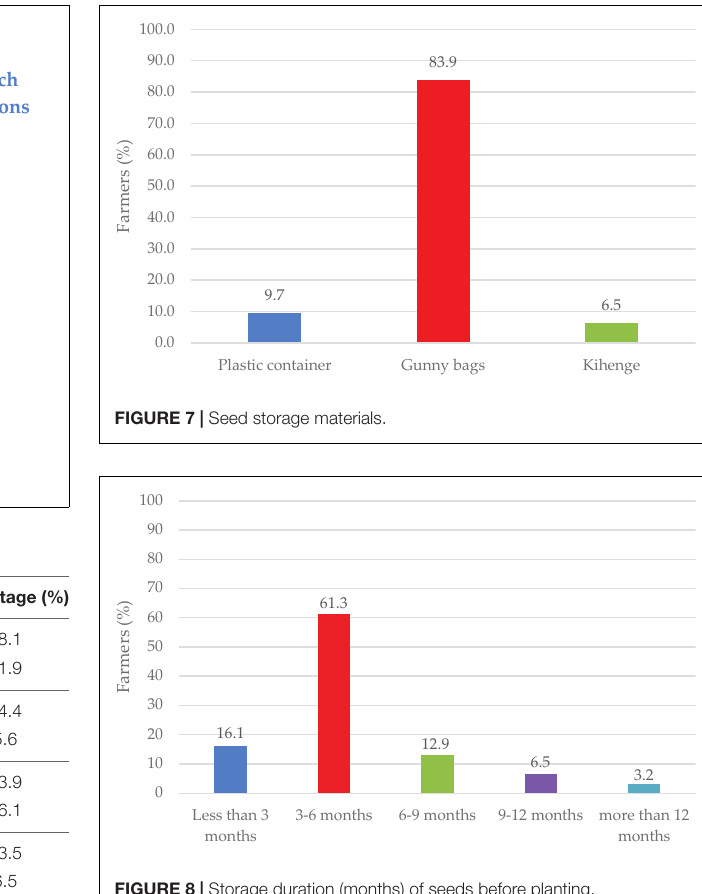
FIGURE 8 | Storage duration (months) of seeds before planting.